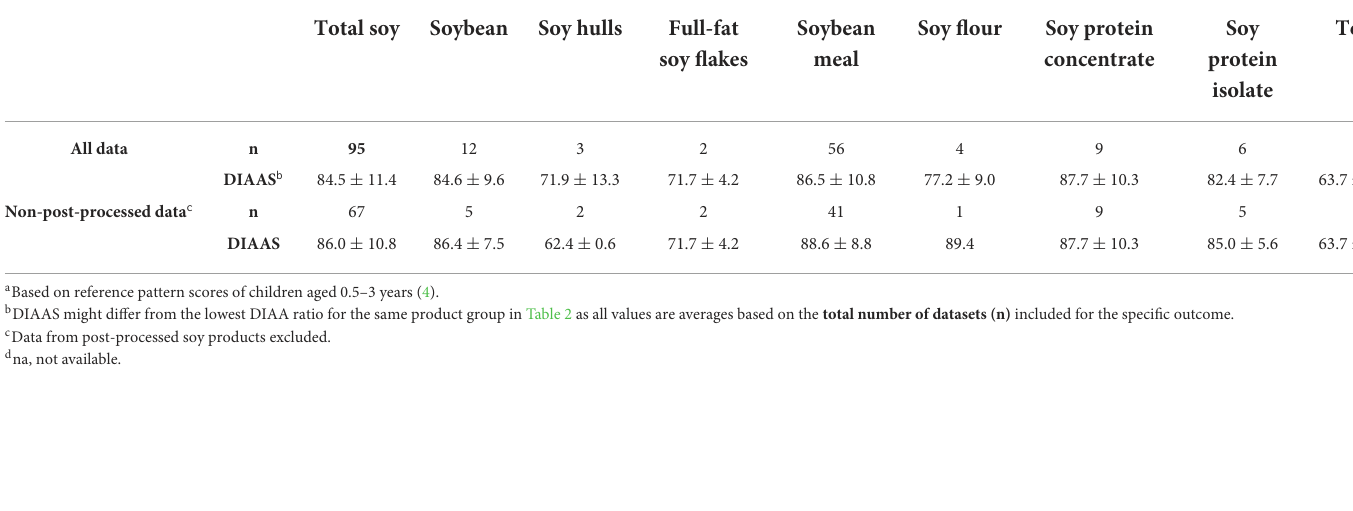
TABLE 3 DIAAS (%) a (mean ± SD) for total soy and soy product groups, calculated from all available data and after excluding post-processed soy